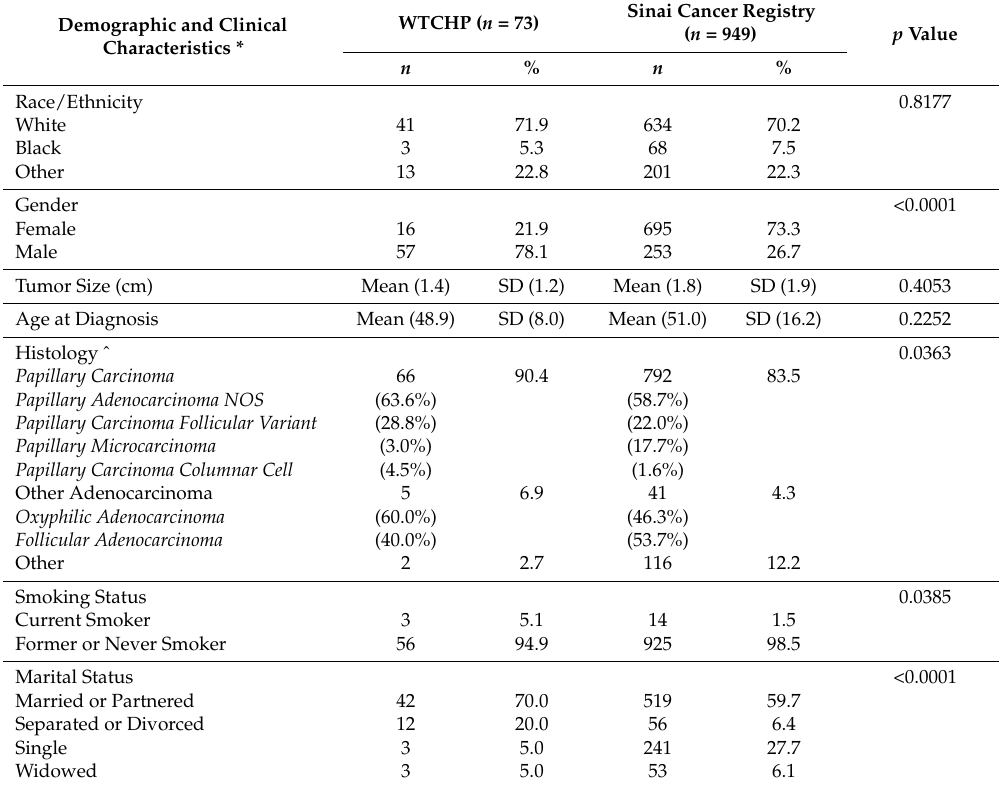
Table 1. Description of World Trade Center Health Program (WTCHP) and Mount Sinai Registry thyroid cancer cases.